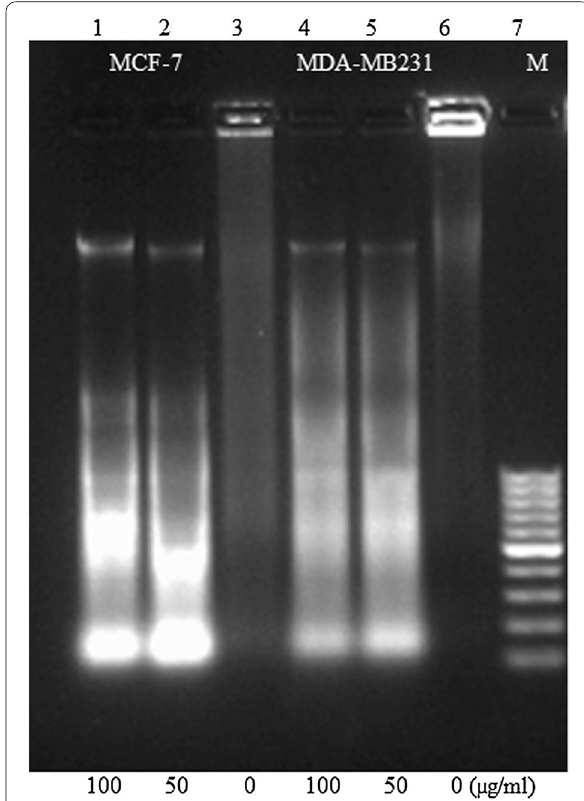
Fig. 7 DNA fragmentation assay: Lane 1 treated with 100 µg/ml; 2 treated with 50 µg/ml; 3 MCF-7 (untreated); 4 MDA-MB231 treated with 100 µg/ml; 5 treated with 50 µg/ml; 6 untreated; and 7 100 bp DNA